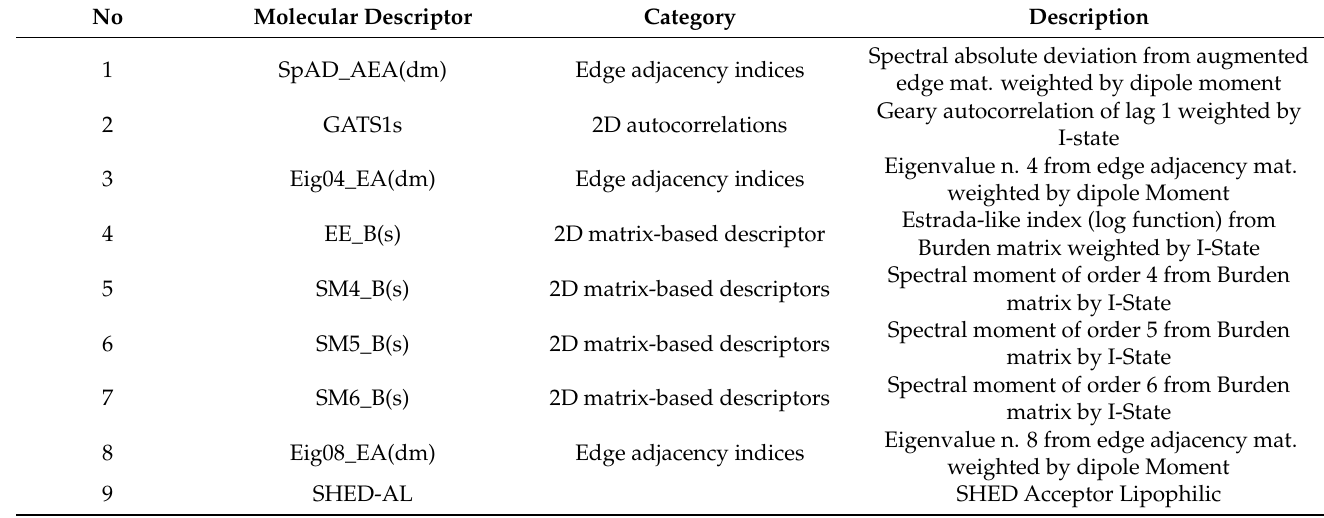
Table 3. Molecular descriptors with respective categories and